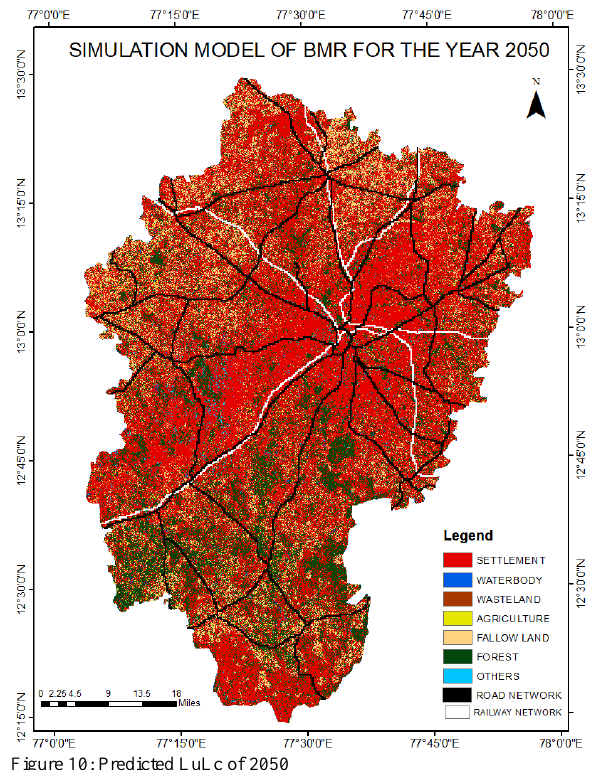
Figure 10: Predicted LuLc of 2050 The wasteland class is observed to gradually decrease in its area since 2011 (9.47%) and is predicted to decrease more by 2050 (0.9%). The agriculture class has witnessed an overall change in its area from 19.43% in 1981 to 5.38% in 2021 and is predicted to change as 3.03% in 2050. Fallow land is seen to be decreasing from 47.99% in 1981 to 18.74% in 2021 and is predicted to further decrease to 11.68% in 2050. The Forest class has witnessed an overall increase in its area from 13.97% in 1981 to 17.56% in 2021 and is predicted to increase to 23.03% in 2050.